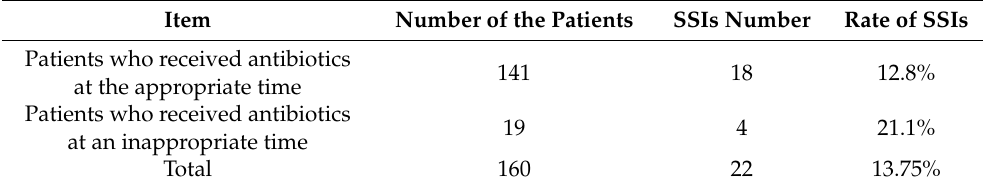
Table 6. The overall SSI